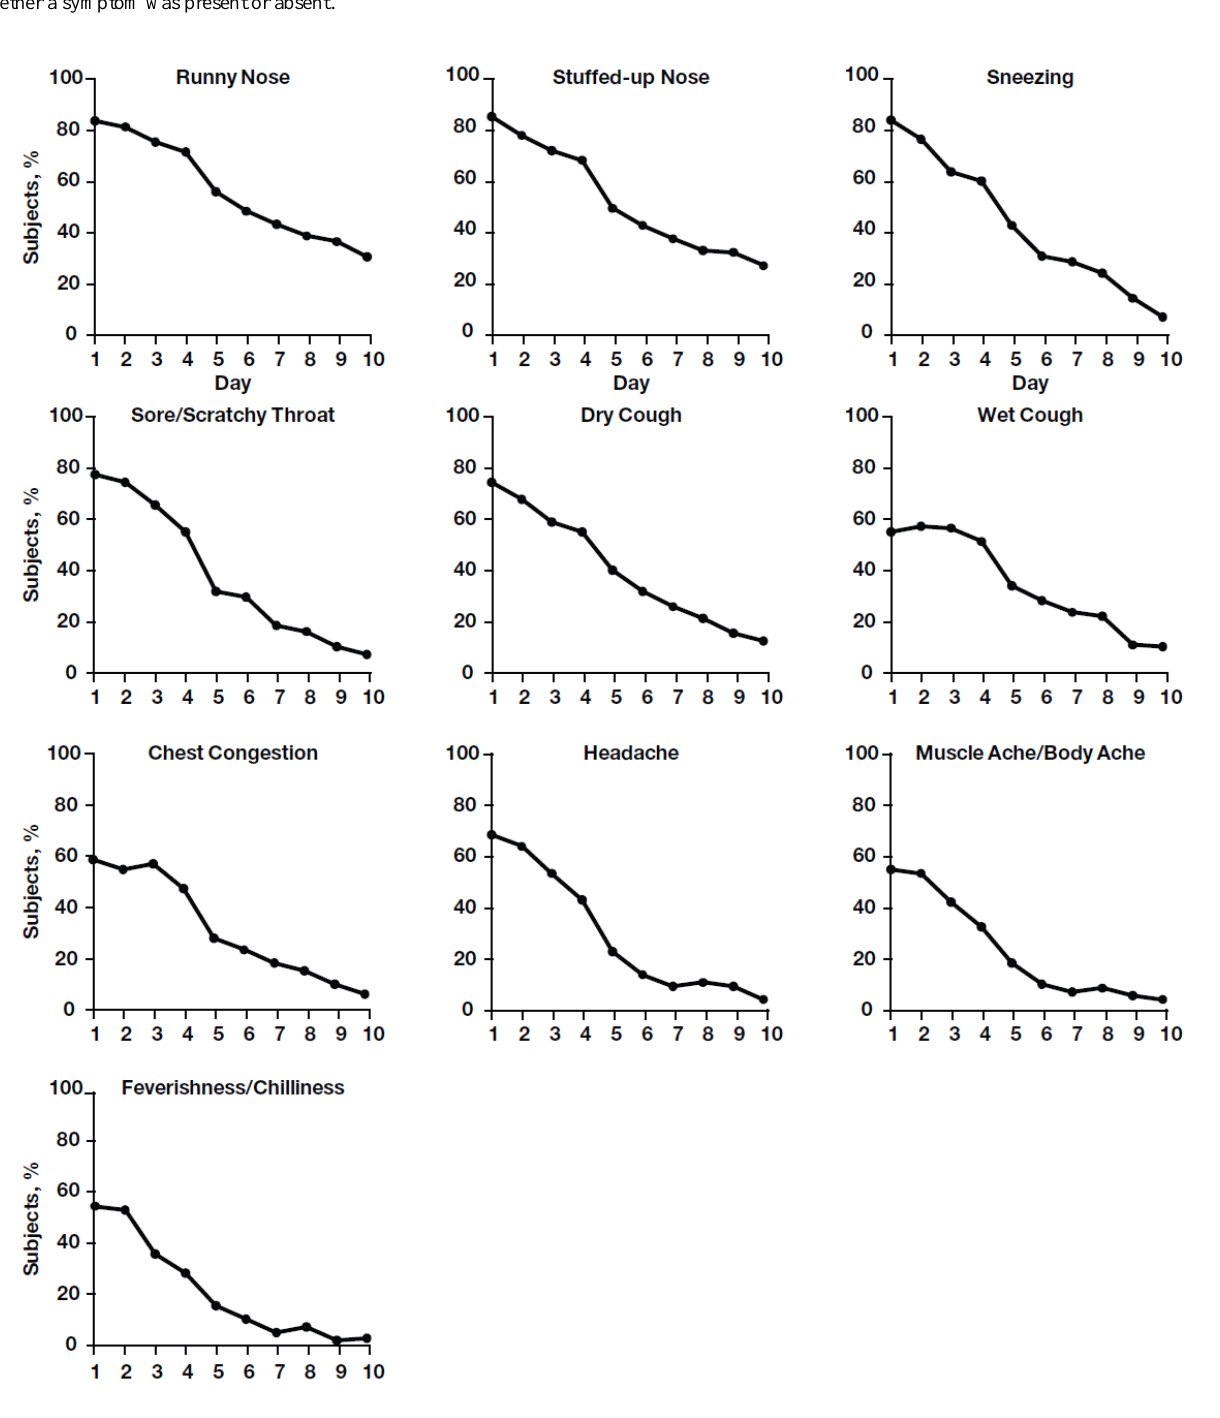
Figure 2. Average daily prevalence of individual cold symptoms. From the day of onset, parents of children with colds (n=134) were asked to report whether a symptom was present or